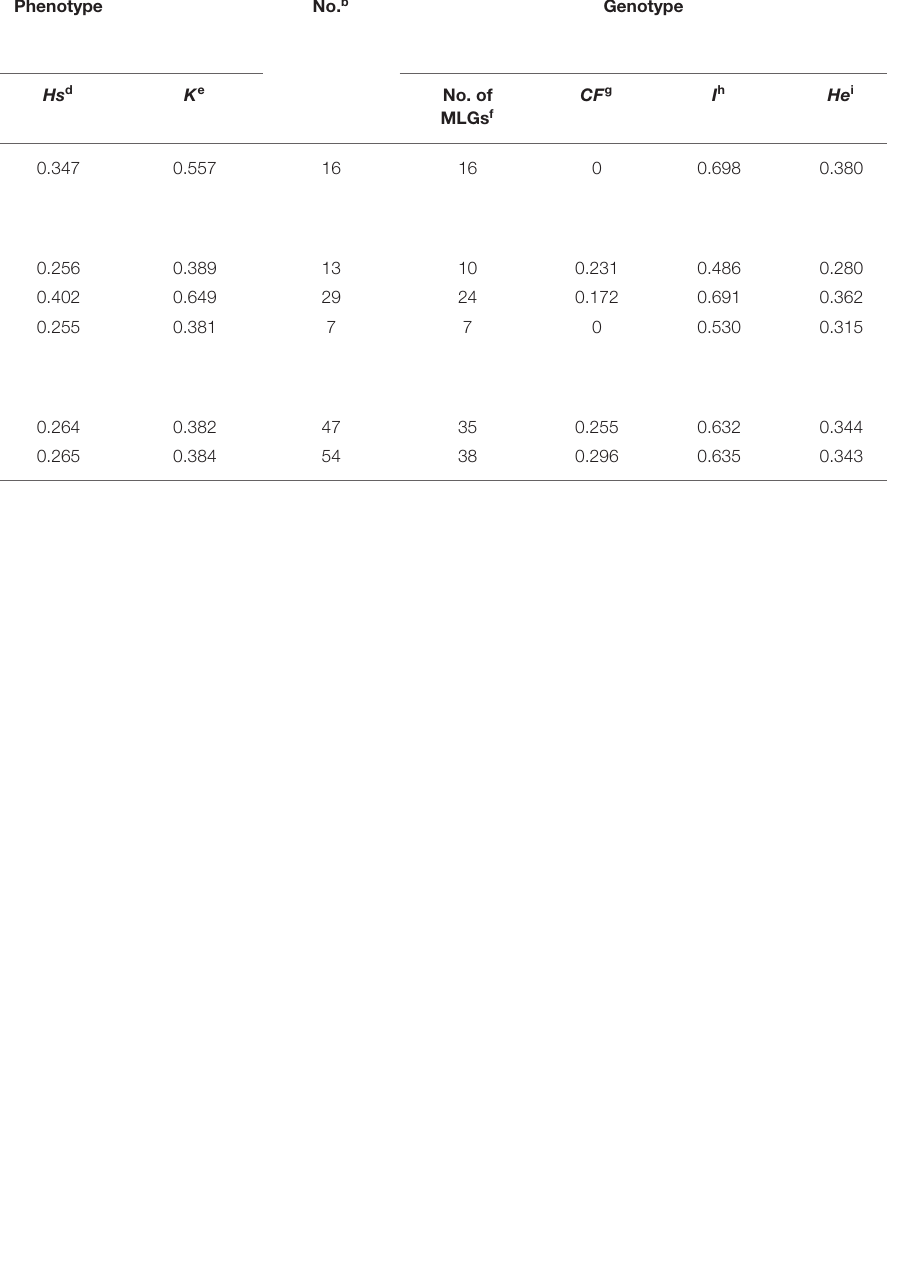
CF g He No. of MLGs f